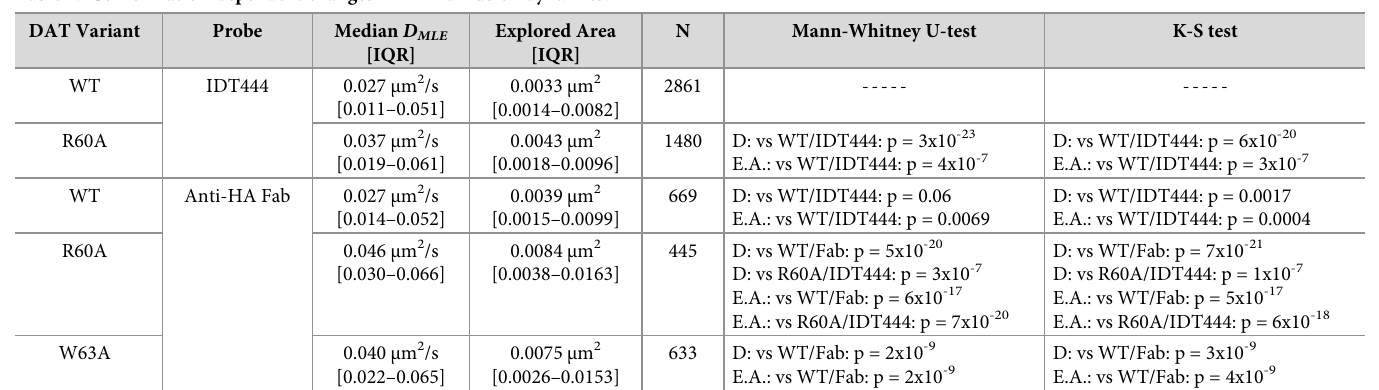
Table 2. Conformation-dependent changes in DAT diffusion